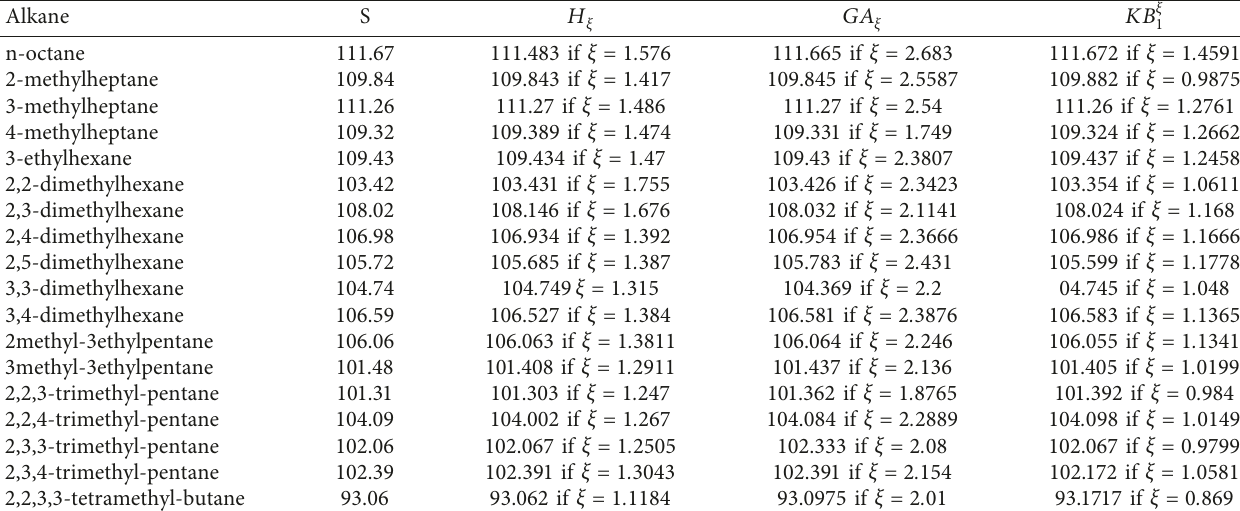
Table 2: Experimental values of entropy(S) and the corresponding values of generalized form of harmonic index, geometric arithmetic index, and first Kulli–Basava index of octane isomers for different values of ξ